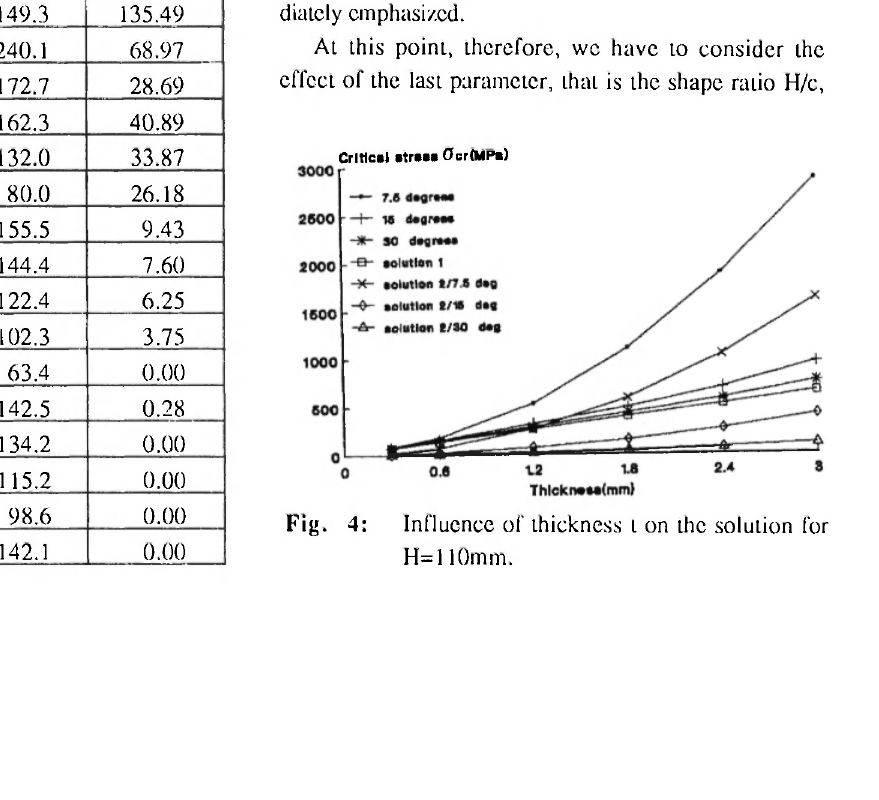
4: Influence of thickness ι on the solution for